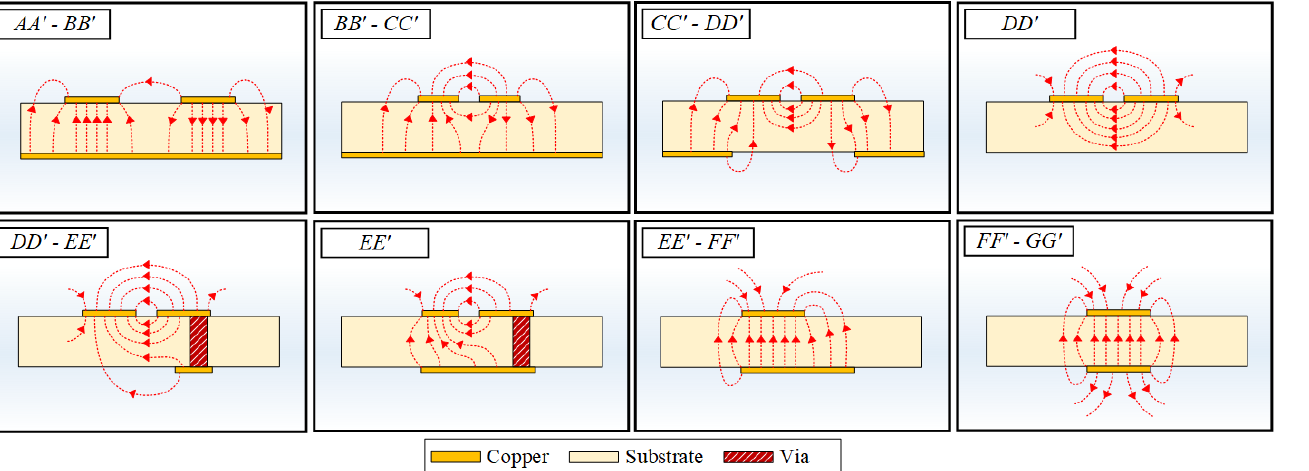
Figure 13. Top and bottom views of the proposed DL-to-PSL transition. Table 3. Design parameters of the DL-to-PSL transition.